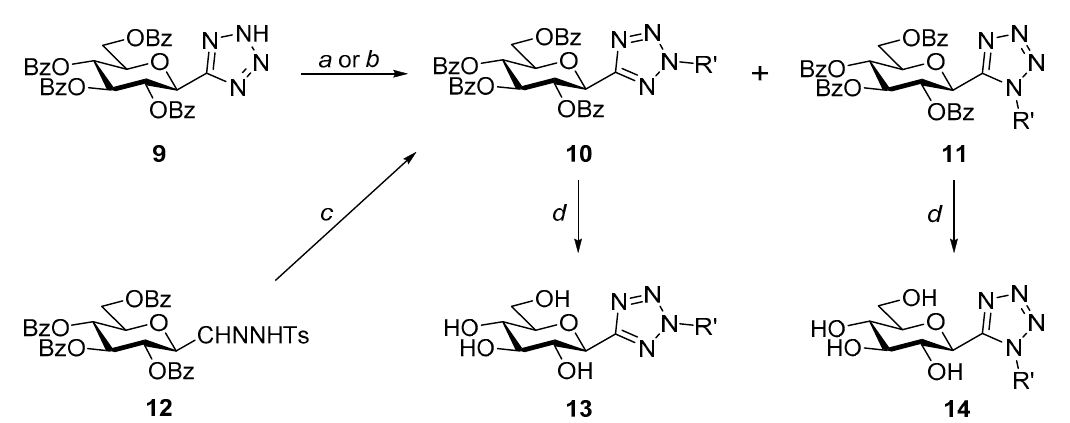
Molecules 2017 , 22 , x FOR PEER REVIEW Table 3. Synthesis of 5-( β - D -glucopyranosyl)- N -substituted-tetrazoles. Table 3. Synthesis of 5-( β - D -glucopyranosyl)- N -substituted-tetrazoles.